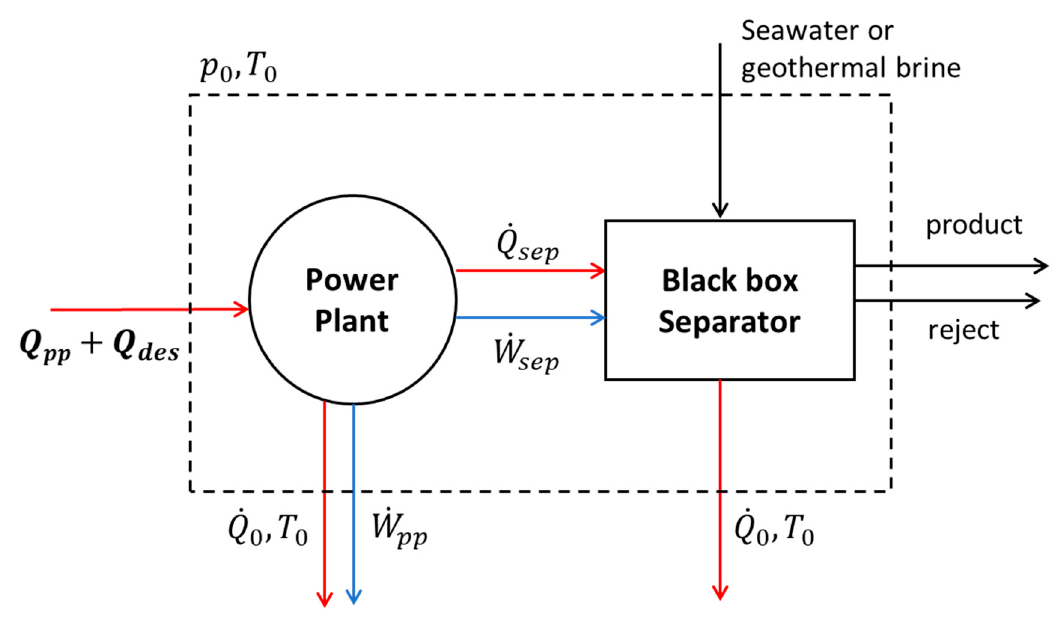
Figure 2. Control volumes for an arbitrary black box chemical separator in a dual purpose water/energy plant, adapted from Mistry and Lienhardt [38,42,43].